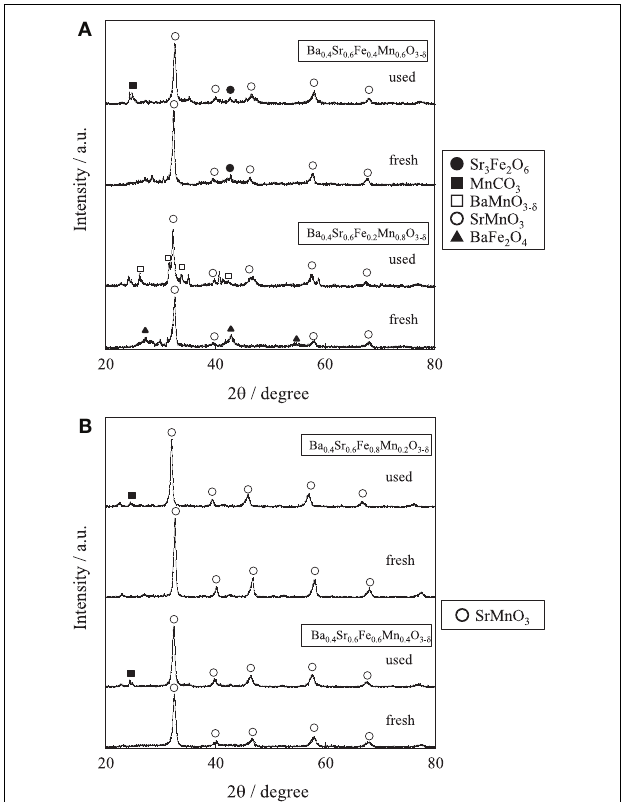
FIGURE 4 | XRD patterns for (A) Ba 0 . 4 Sr 0 . 6 Fe y Mn 1 − y O 3 − δ ( y = 0 . 2 and 0.4) catalysts and (B) Ba 0 . 4 Sr 0 . 6 Fe y Mn 1 − y O 3 − δ ( y = 0 . 6 and 0.8) catalysts.